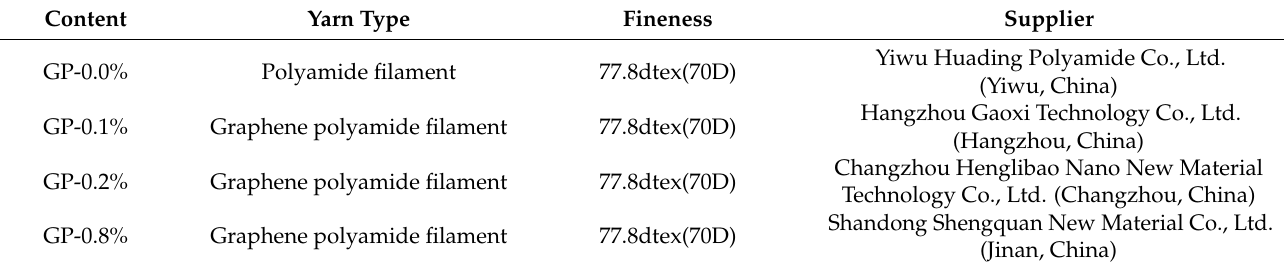
Table 1. Veil materials and